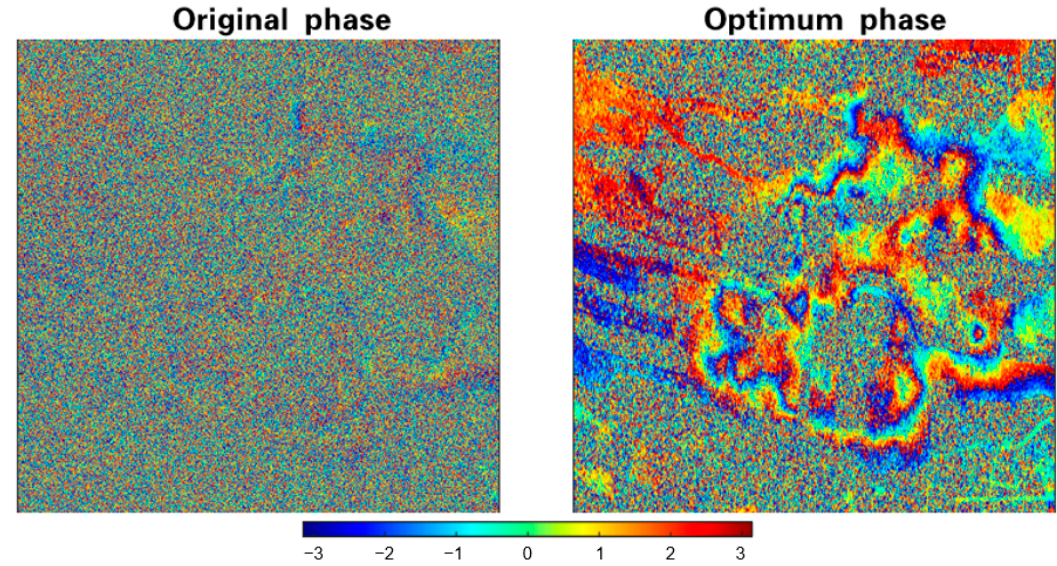
Figure 11. The SHP numbers .